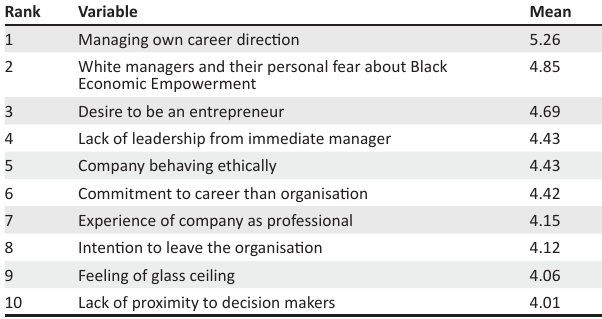
TABLE 10: The most important variables that drive mobility.